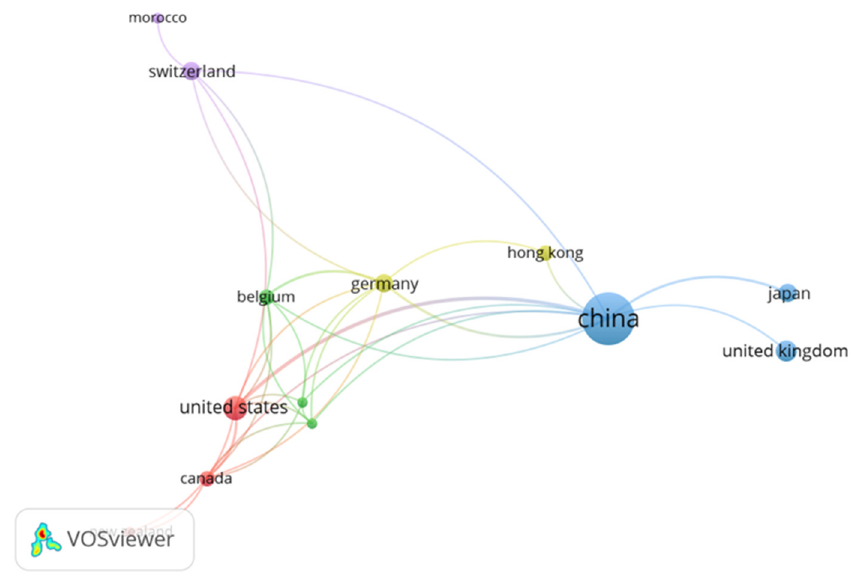
Figure 5. Cluster network analysis of the principal connections among the authors’ countries of the reviewed articles.